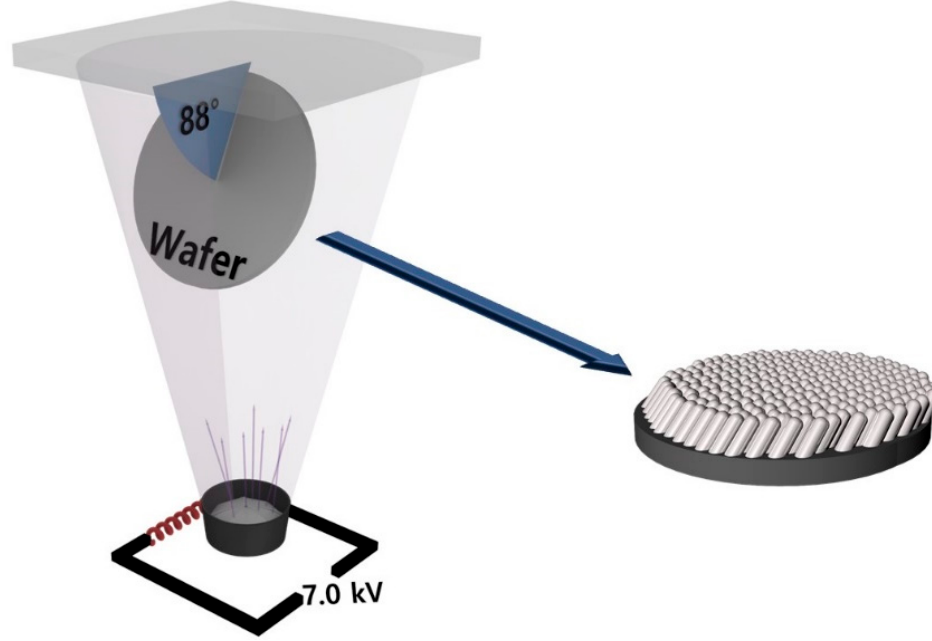
Figure 1. Schematic image of oblique angle deposition with electron beam evaporator.